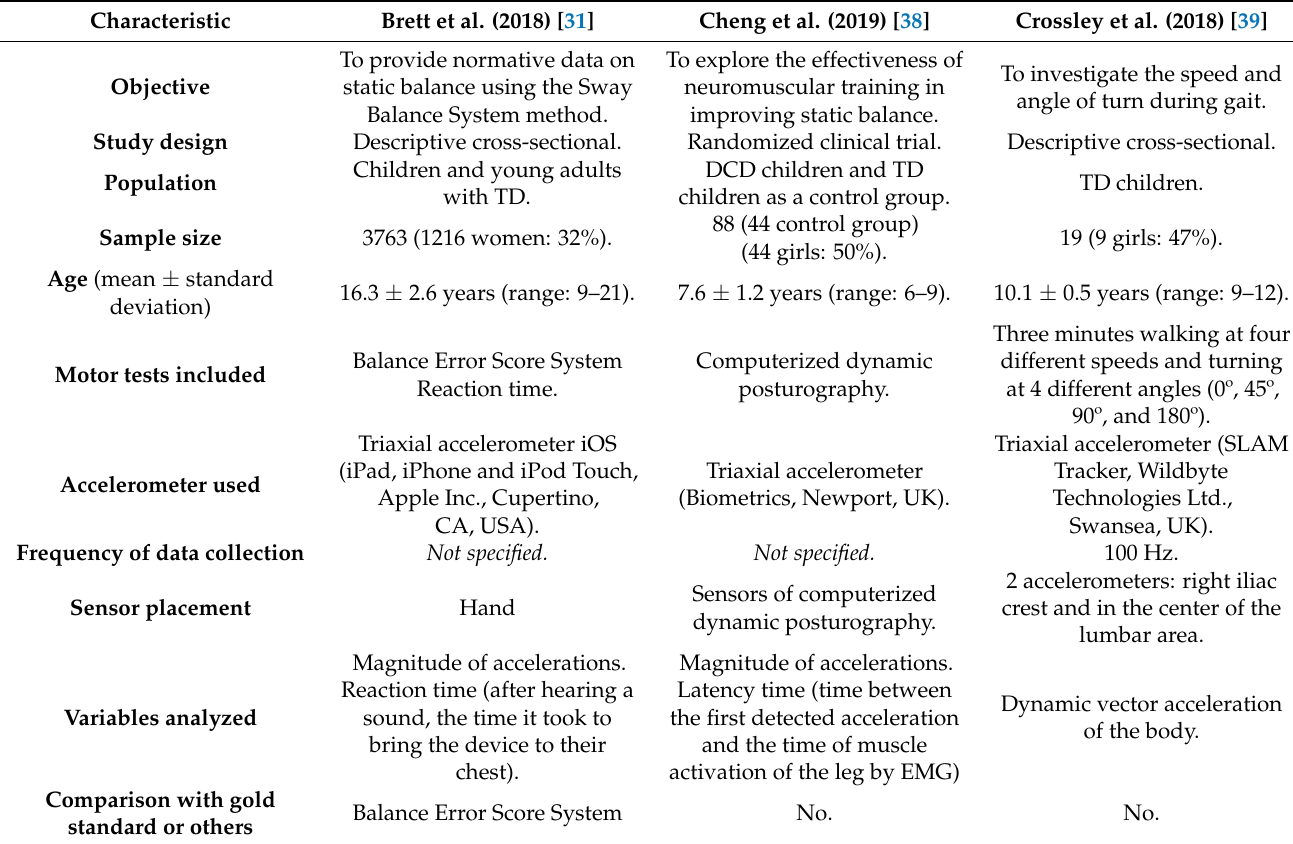
Table 1. Methodological characteristics of the articles